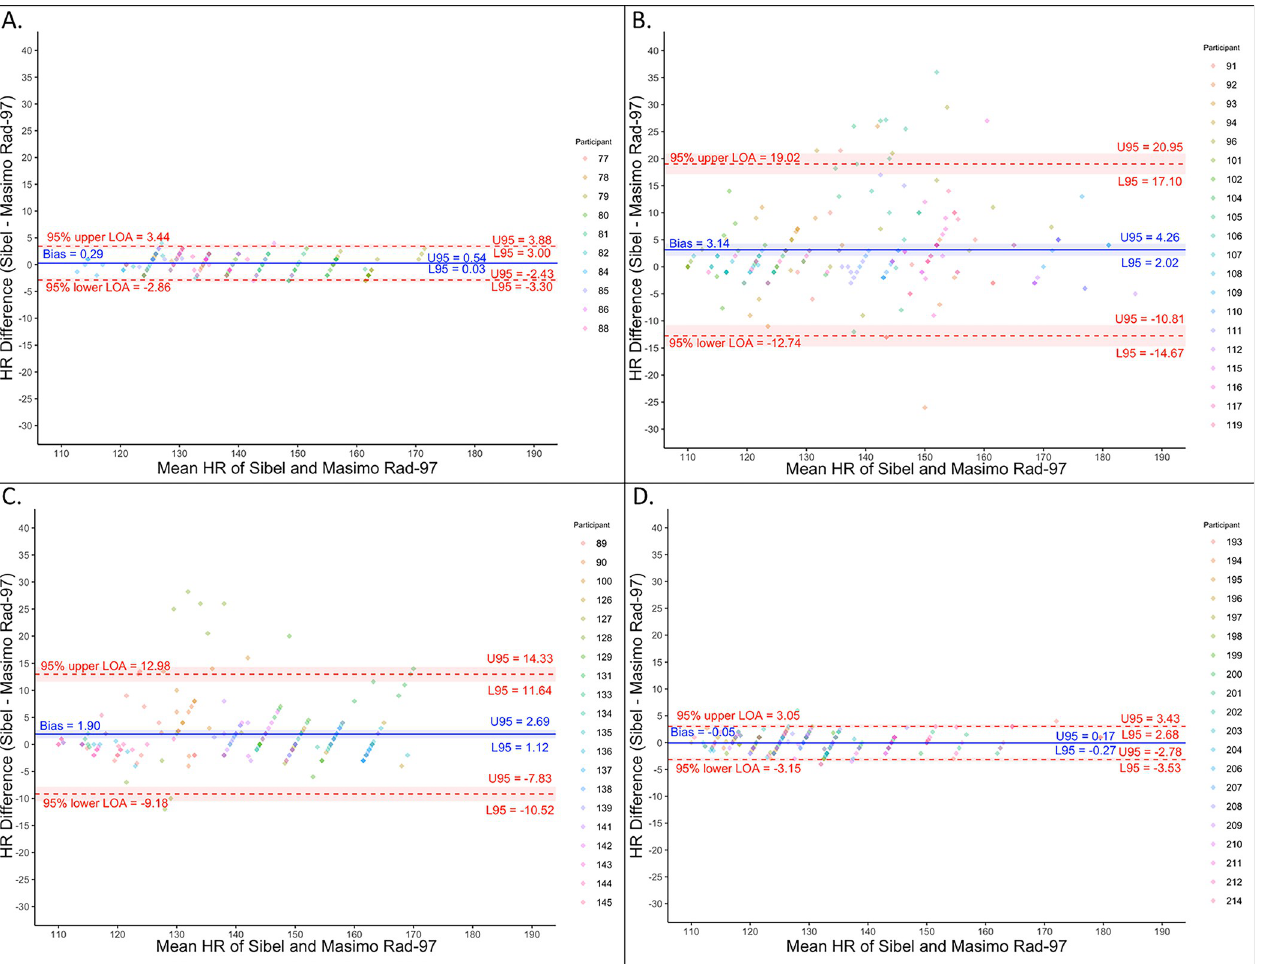
Fig 1. Bland-Altman plots for heart rate (HR). (A) Open-label round. (B) Closed-label round one. (C) Closed-label round two. (D) Closed-label round three. Colors indicate which enrolled neonate is associated with the measurement